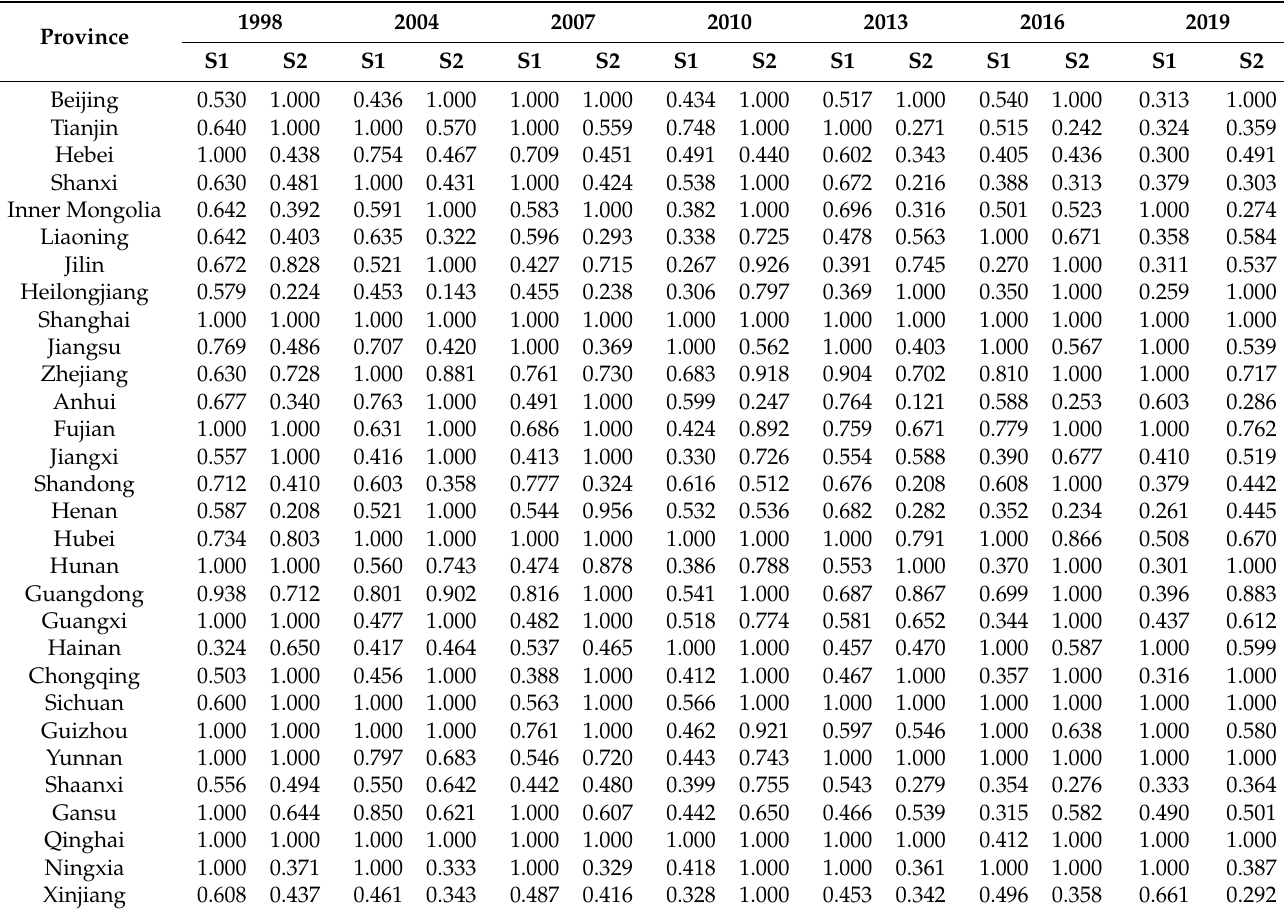
Table 3. The environmental efficiency level by link of the power industry in China’s 30 provinces of 1998–2019.